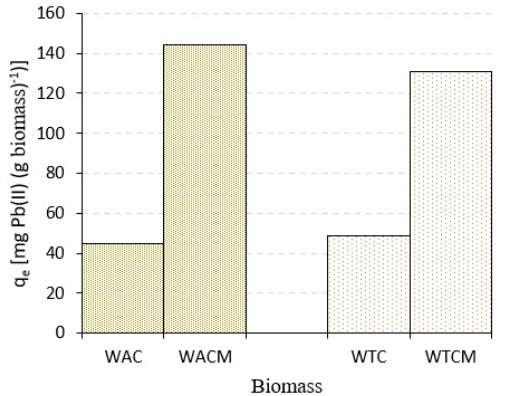
Figure 1. Pb(II) adsorption capacity q e for Arabica -coffee and Theobroma -cocoa wastes, untreated (WAC and WTC) and treated (WACM and WTCM) biosorbents. Initial Pb(II) concentration, C 0 = 48.42 mg L − 1 , biosorbent dose = 2 g L − 1 , pH 4.